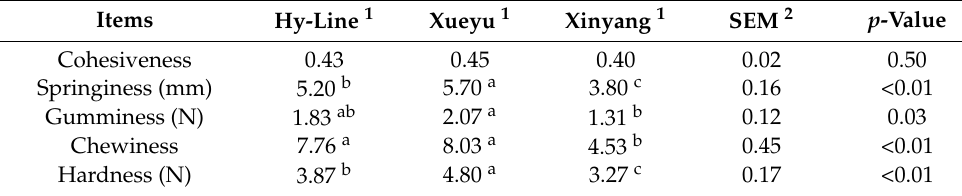
Table 6. Texture of egg yolks from Hy-Line, Xueyu, and Xinyang laying hens.